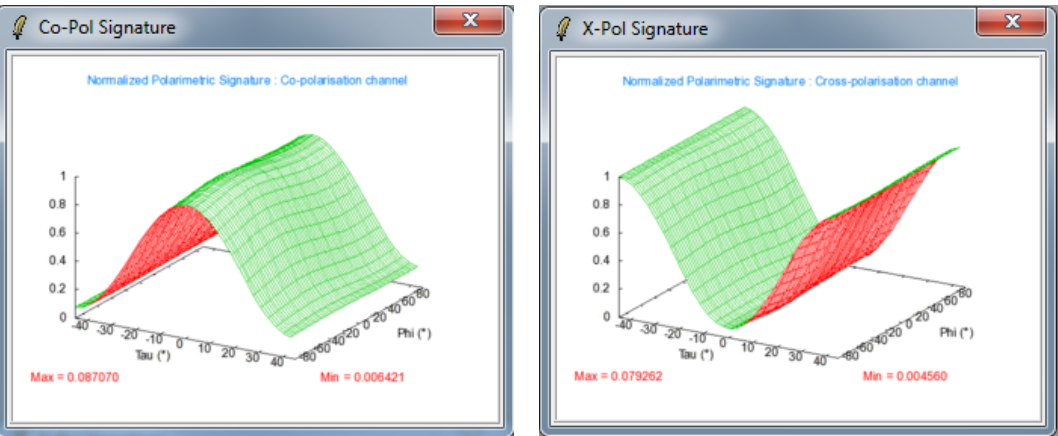
Figure 5. (a) Wadi deposits polarimetric signature